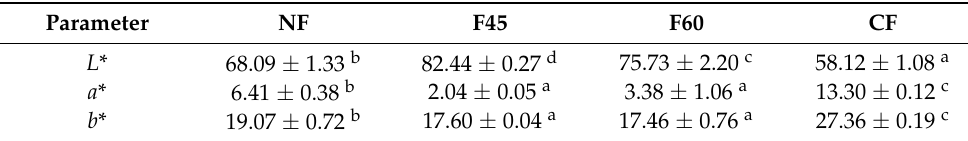
Table 5. Color parameter of Maya nut